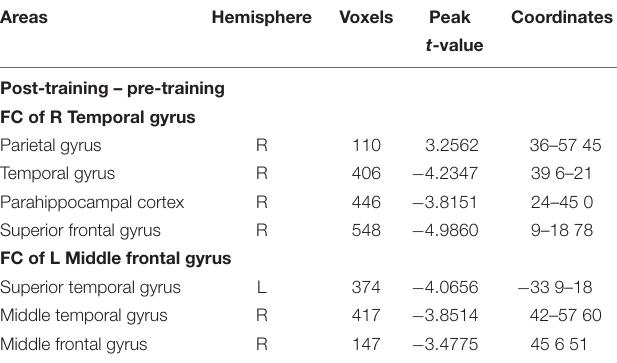
TABLE 2 | Pre–post differences in seed-based FC in altered ReHo regions.